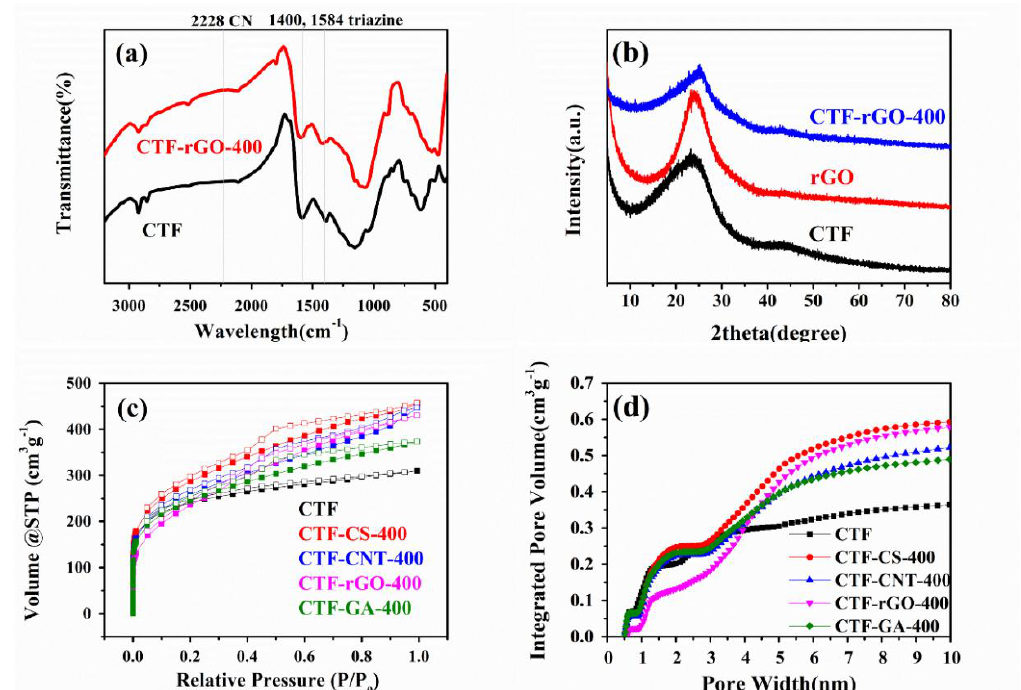
Figure 1. ( a ) FT-IR spectra and ( b ) X-ray diffraction (XRD) patterns of the synthesized covalent triazine-based framework (CTF) and the CTF-rGO composite; ( c ) nitrogen sorption isotherms (solid and hollow squares correspond to the adsorption and desorption process respectively); and ( d ) cumulative pore volume plot vs. pore width of CTF and its composites. rGO: reduced graphene oxide.